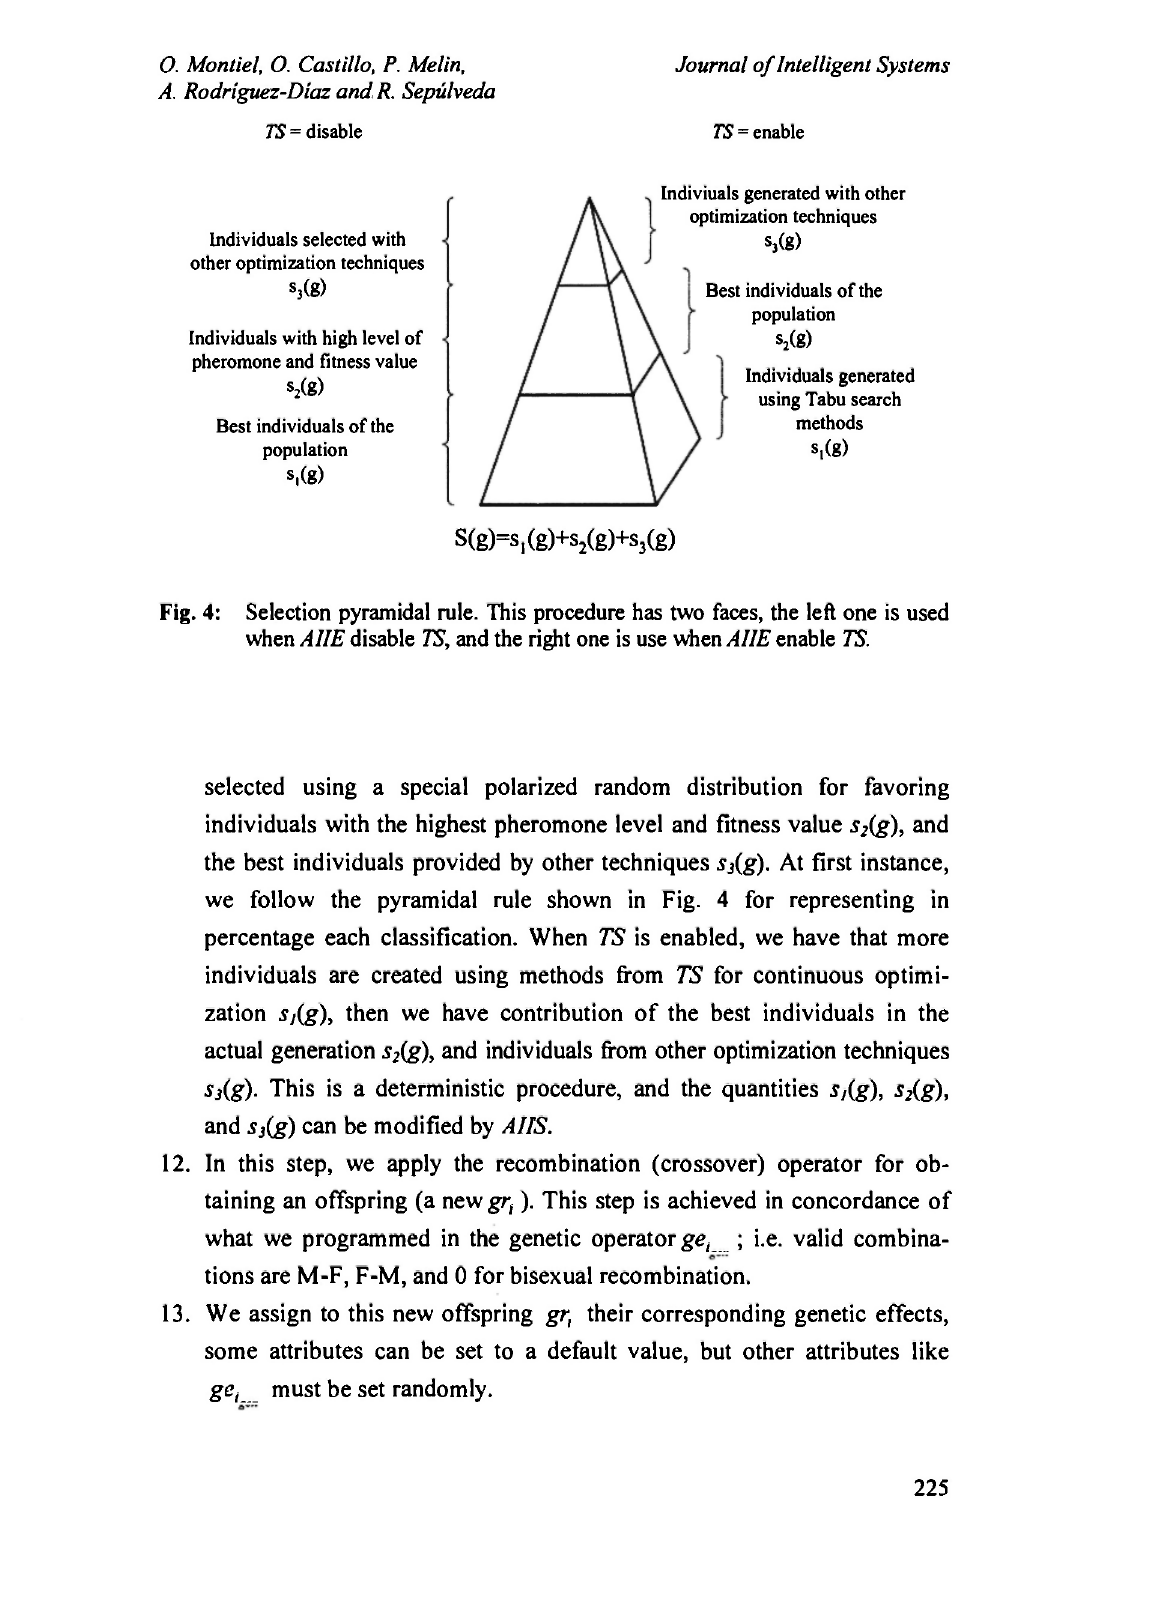
Selection pyramidal rule. This procedure has two faces, the left one is used when AIIE disable TS, and the right one is use when AIIE enable TS.